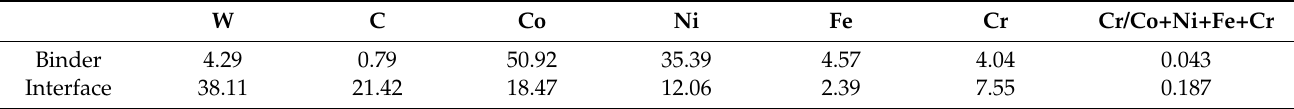
Table 2. EDS composition (at.%) in the binder and at the interface in Alloy 5.